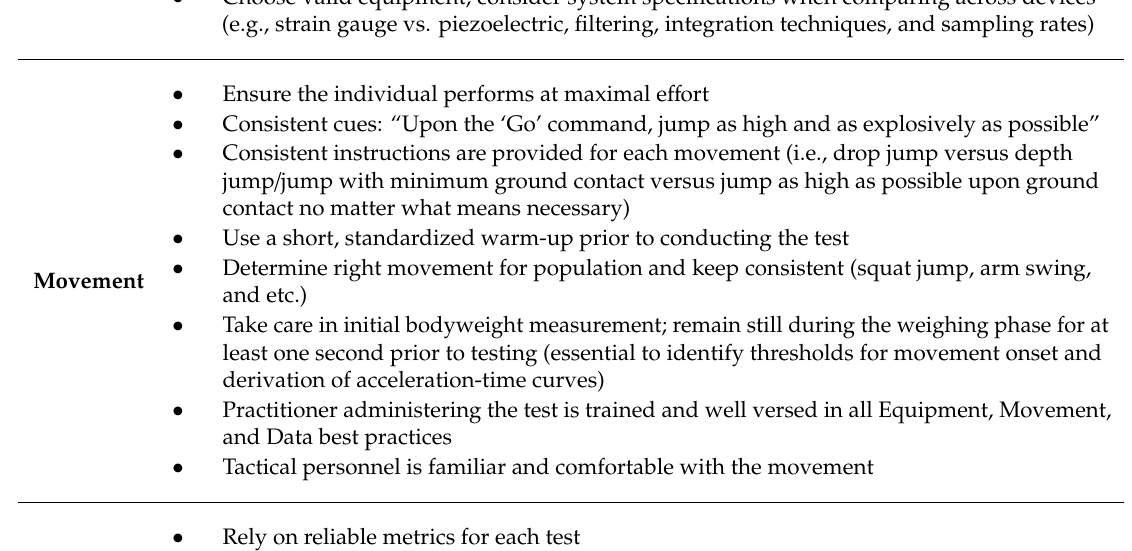
Table 1. Summary of Force Plate Equipment, Movement, and Data Best Practices for NP Monitoring.